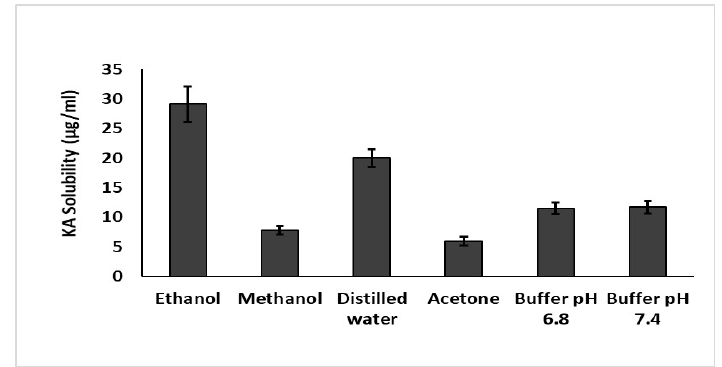
Figure 4. Solubility studies of KA in different solvents.